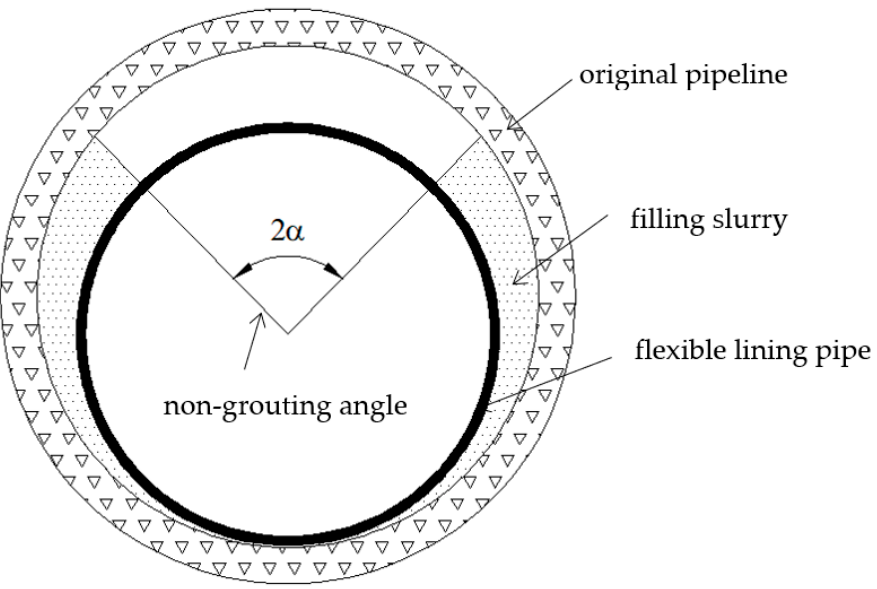
Figure 1. Schematic diagram of rigid–flexible composite lining structure. The theoretical schematic diagram of uniform compression arch buckling with fixed ends is shown in Figure 2. Both ends of A and B are fixed ends, and the angle between A and B is 2 α . The arch is subjected to uniform pressure P . Assuming that after buckling of the arch, there is not only horizontal pressure S , but also direct shear force Q at the midpoint C , and the arch is regarded as the cable curve of uniform pressure and w is used to represent the radial displacement of the center, then the bending moment M of any cross section m determined by angle θ is as follows